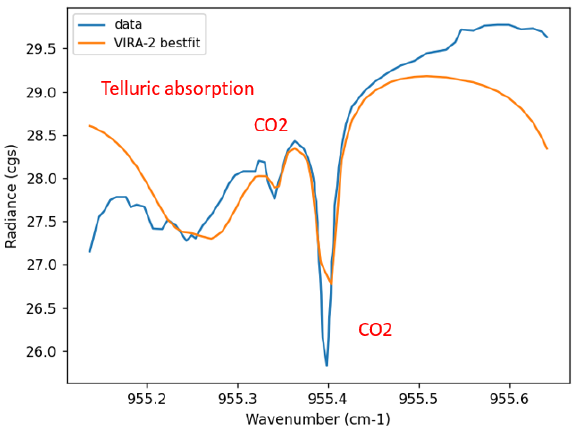
Figure 12. Best fit models — Phosphine. Orange—VIRA-2 best-fit. Blue—data. The main absorption features are identified. Below 955.2 cm − 1 and above 955.4 cm − 1 , the simulation deviates from the data. The uncertainty of the datapoints of the observations is approximately 5%. The error of the simulations is approximately